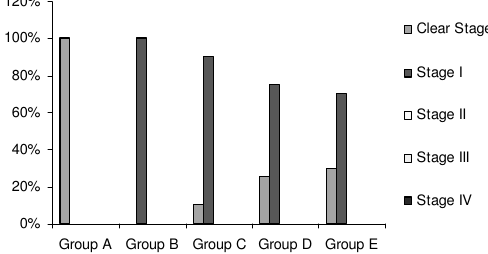
Figure 1. Graphical representation of effect of Triphala ghrita on galactose- induced cataract in rats after 7 days of the